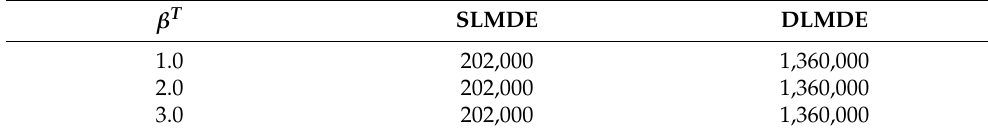
Table 2. Number of function evaluations required by both methods for example 1. β